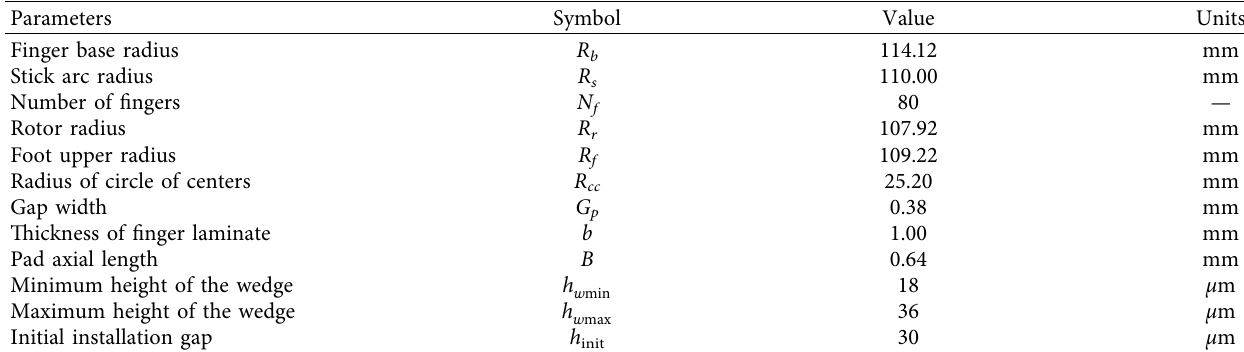
Figure 10: Calculation flow of bearing characteristic. Table 1: Parameters of noncontacting finger